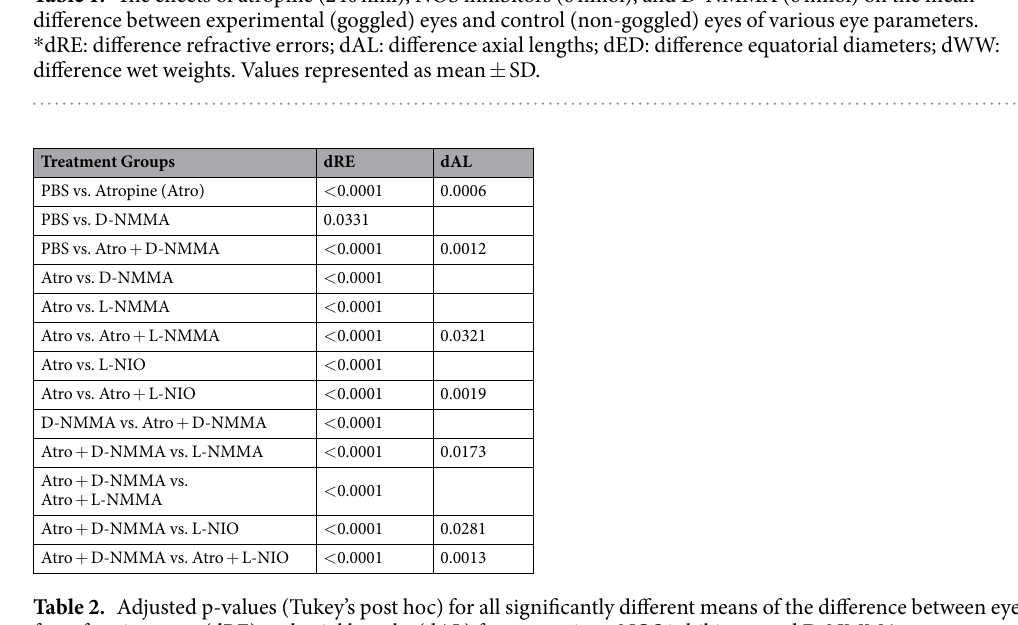
Table 2. Adjusted p-values (Tukey’s post hoc) for all significantly different means of the difference between eyes for refractive error (dRE) and axial lengths (dAL) from atropine-, NOS inhibitor-, and D-NMMA-treatment experiments. * dRE: difference refractive errors; dAL: difference axial